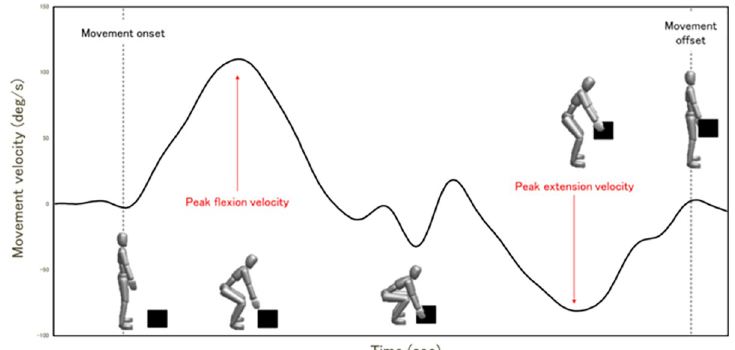
Fig 2. Time series variation of the velocity of trunk movement during lifting. The kinematic data were extracted from the peak trunk flexion velocity and the peak trunk extension velocity.